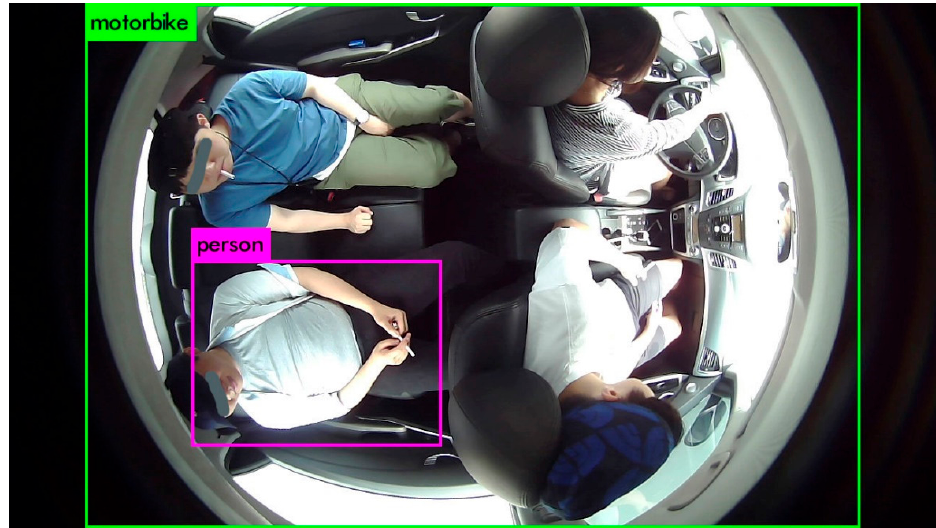
Figure 14. Direct inference through pretrained weights.